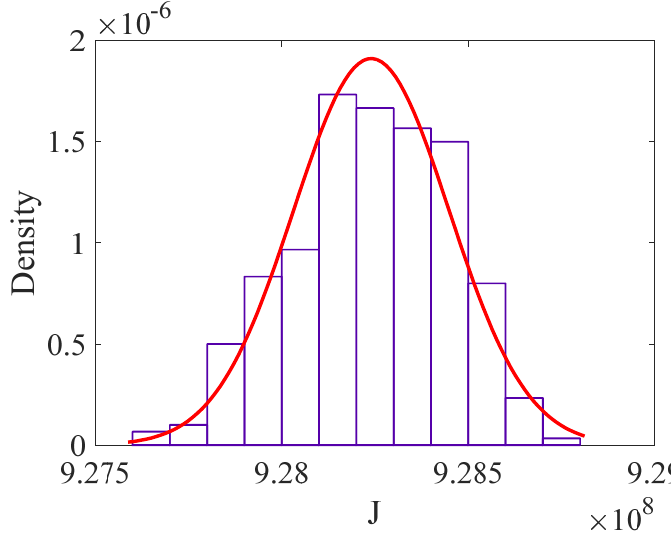
Figure 9. Probability distribution of the vehicle-related parameter J .